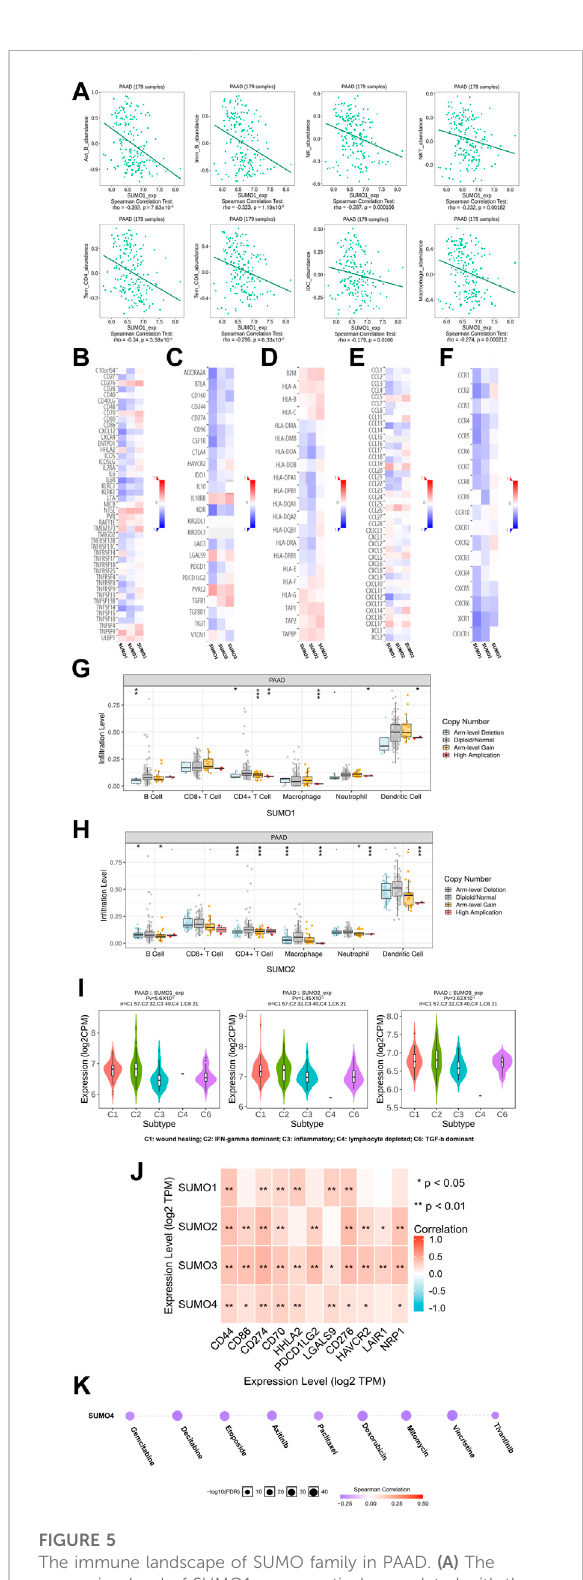
FIGURE 5 The immune landscape of SUMO family in PAAD. (A) The expression level of SUMO1 was negatively correlated with the in fi ltration level of a variety of tumor in fi ltrating immune cells, including Act B, Imm B and Tem CD8; (B – F) The expression level of SUMO1/2 was negatively correlated with